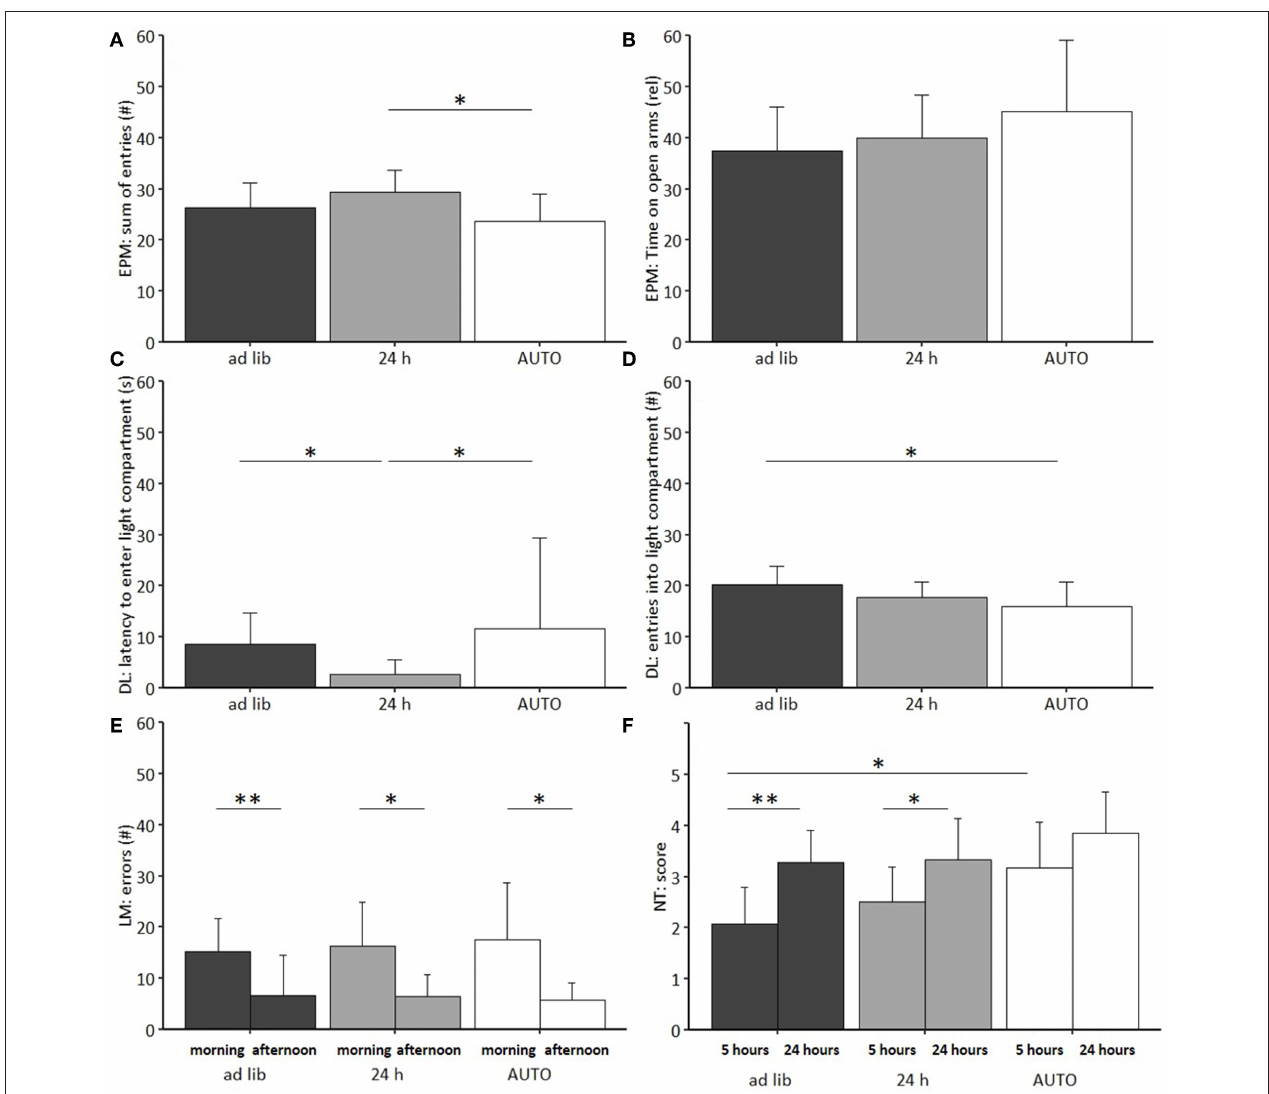
FIGURE 10 | Behavioral tests on anxiety-like and exploratory behavior, spatial learning and nesting behavior. (A) Elevated Plus Maze (EPM): Sum of entries into open and closed arms, (B) EPM: Relative time on open arms, (C) Dark Light (DL): Latency to first enter the light compartment, (D) DL: Number of entries to light compartment, (E) Labyrinth-Maze Test (LM): Number of errors per trial. (F) Nest Test (NT): Score after 5 and 24h. Ad lib , Ad libitum group, 24h, 24h schedule group; AUTO, Automated feeding routine group. Data presented as mean ± SD. Statistics: Repeated measures ANOVA, post hoc : Bonferroni-Holm corrected; sample size: n = 12 per group; * p < 0.05, ** p <